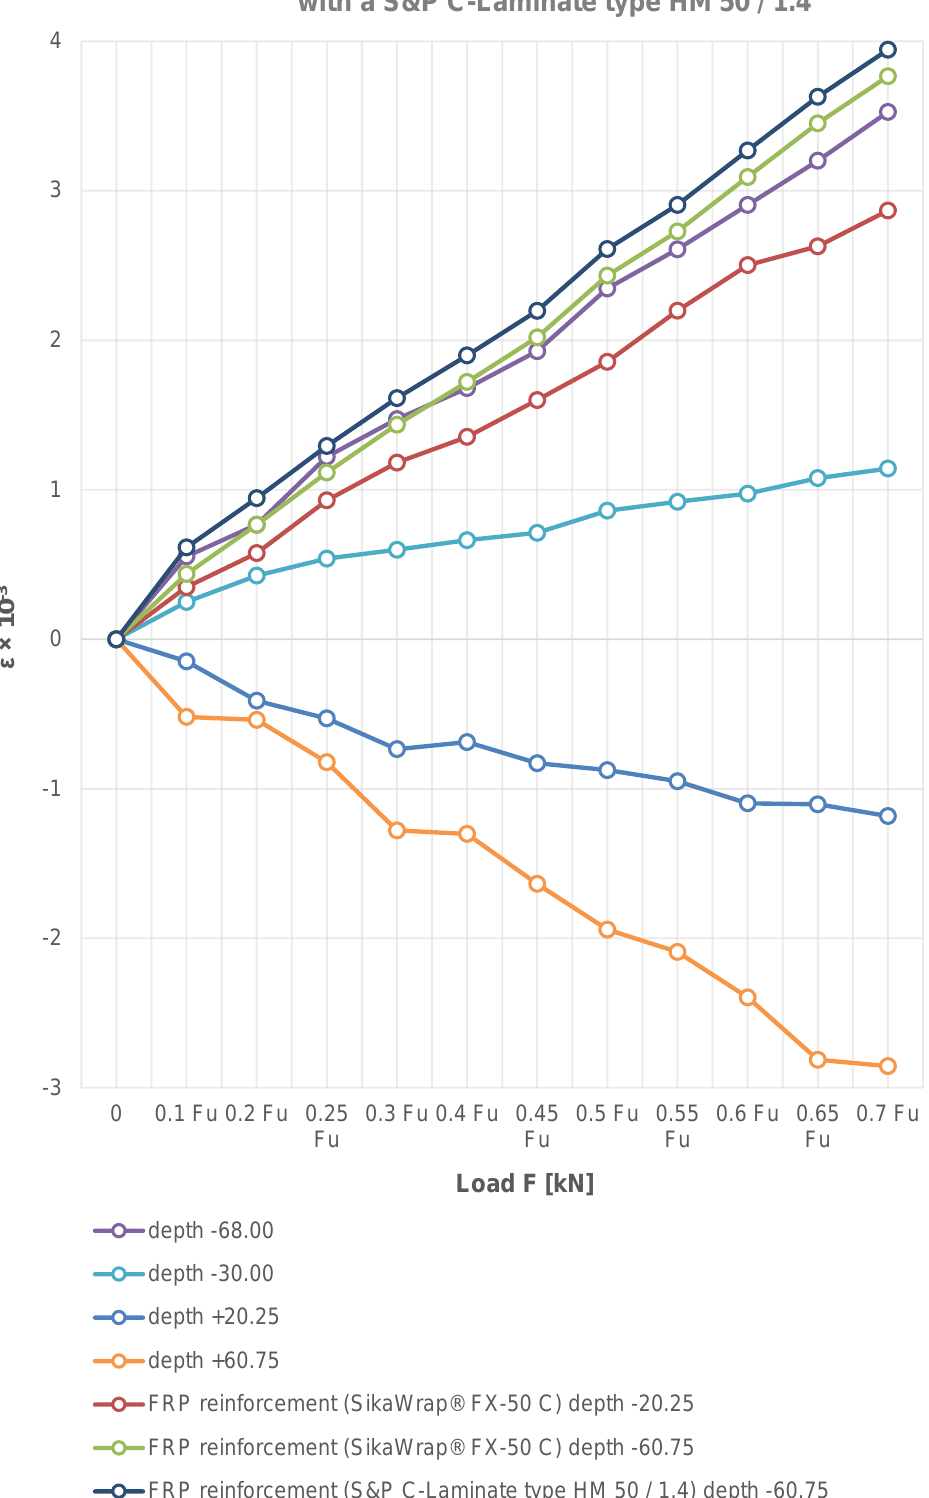
Figure 8. The distribution of deformation in timber beams and FRP materials at the section height. For the group of beams reinforced with carbon cords or ropes and carbon laminates, the compressive strain was slightly lower than the tensile strain at the initial